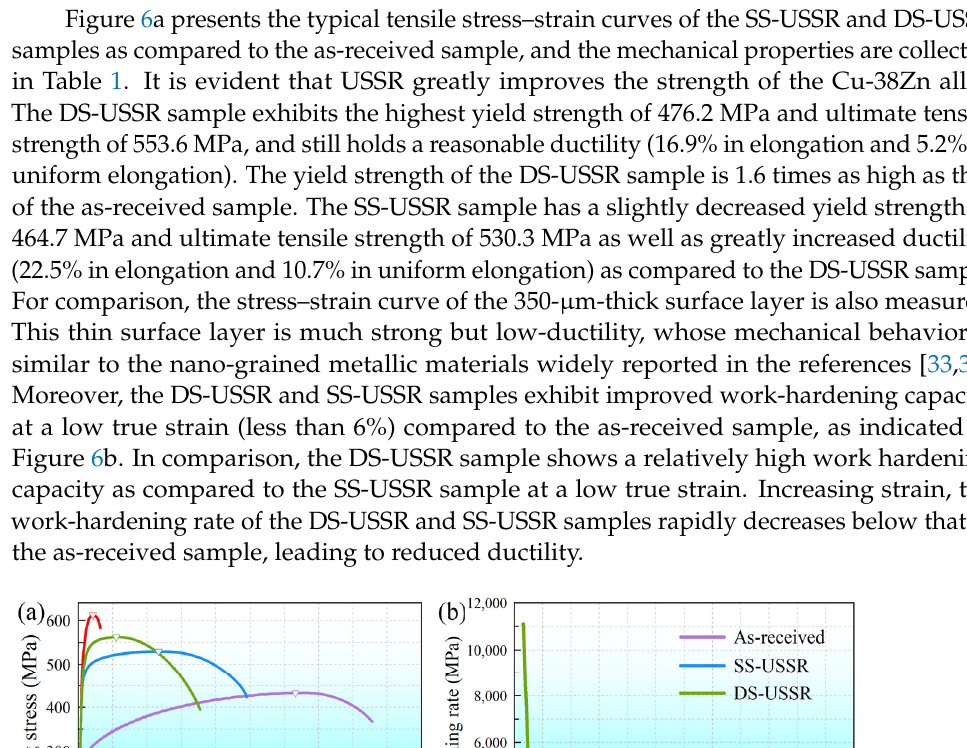
Figure 5. Distribution of micro-hardness along the increasing depth from the topmost surface. For the DS-USSR sample, the depth increases from the first USSR processed side.